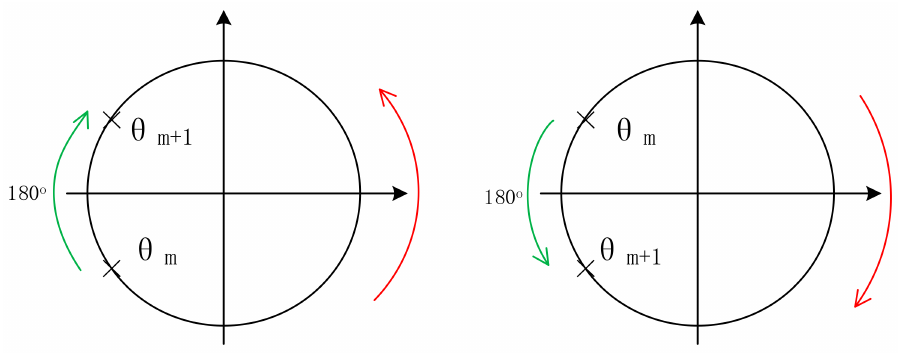
Figure 7. Schematic diagram of the phase jump